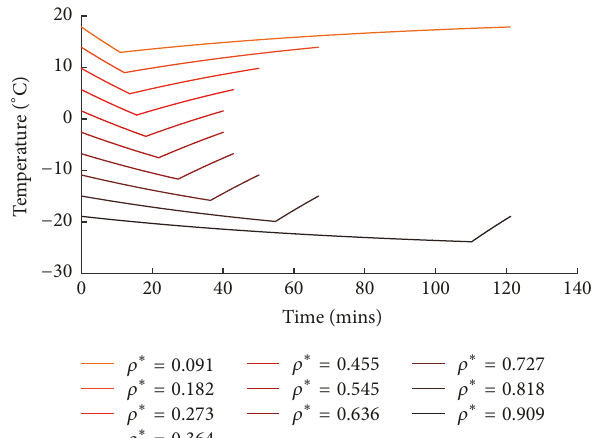
Figure 3: One cycle of the single group solution for different values of 𝜌 ∗ when 𝜌 0 ≈ 0.3355 . They include values that lead to unrealistic results for real fridges but are there to illustrate the effect.